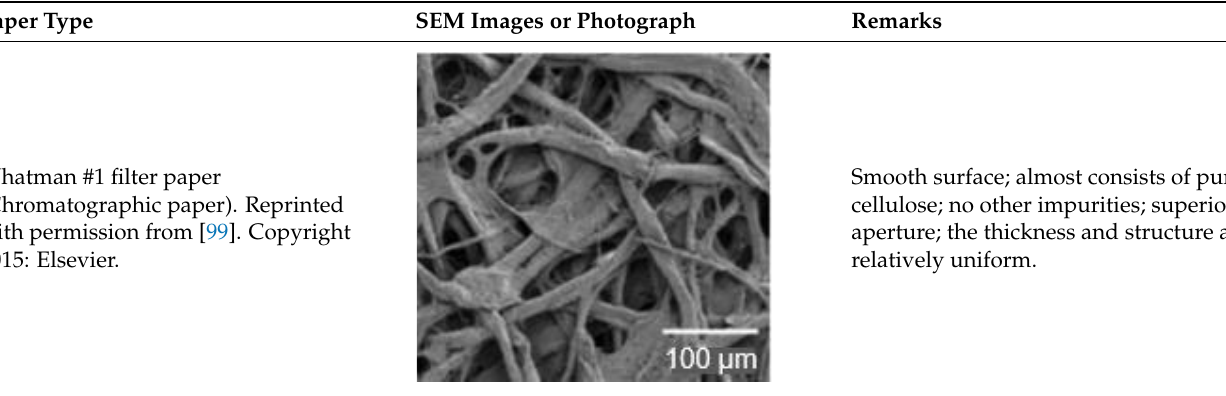
Table 1. Microstructure and characteristics of some cellulose papers.